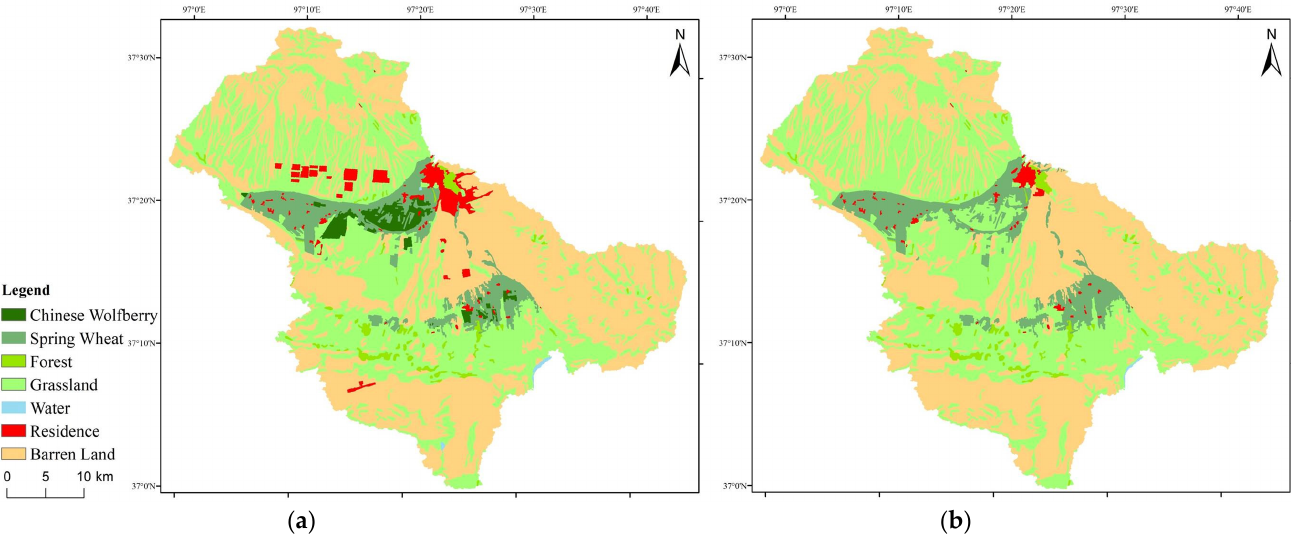
Figure 6. Revegetation status of the study region in ( a ) 2000 and ( b ) 2018. Basin boundaries delineated by the SWAT model were considered as impermeable boundaries to groundwater flow in the MODFLOW model, where the western and eastern outlets of the basin were considered as constant flow boundaries. The river network extracted by the SWAT model was considered to constitute river boundaries in the MODFLOW model. The simulated steady-state groundwater head (Figure 7) was used as the initial head for simulations of transient flow [32]. In addition, the shallow aquifers in the study region were conceptualised as being non-homogeneous and anisotropic according to relevant studies [32], and the groundwater flow was conceptualised as a two ‐ dimen ‐ sional transient flow.